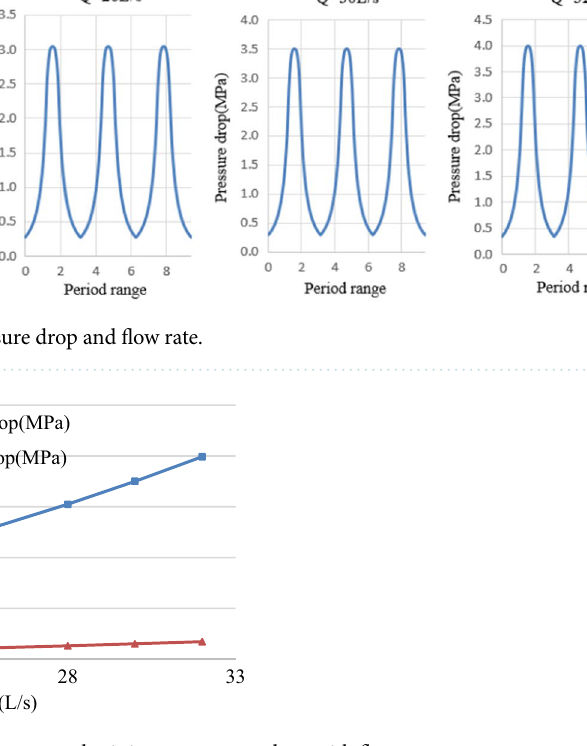
Figure 8. Relationship between maximum and minimum pressure drop with flow